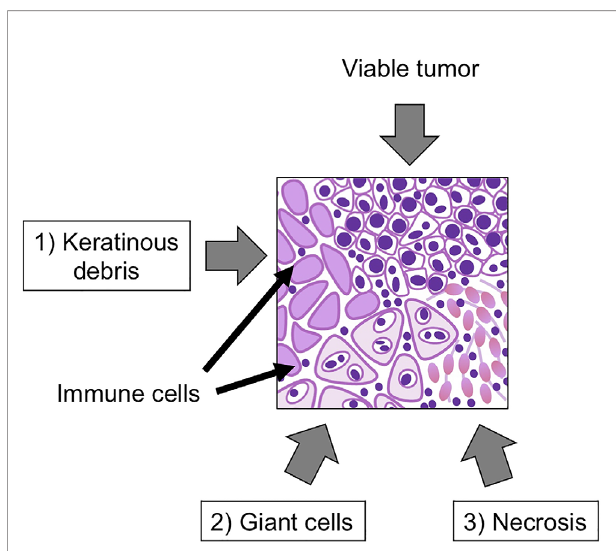
FIGURE 1 | Representative fi gure of pathological tumor response (pTR). Key pathological fi ndings after neoadjuvant immunotherapy include 1) keratinous debris, 2) giant cells, histiocytic reaction and 3) tumor necrosis. The pTR rate is calculated as the area of regions 1-3/(1-3)+area of any remaining